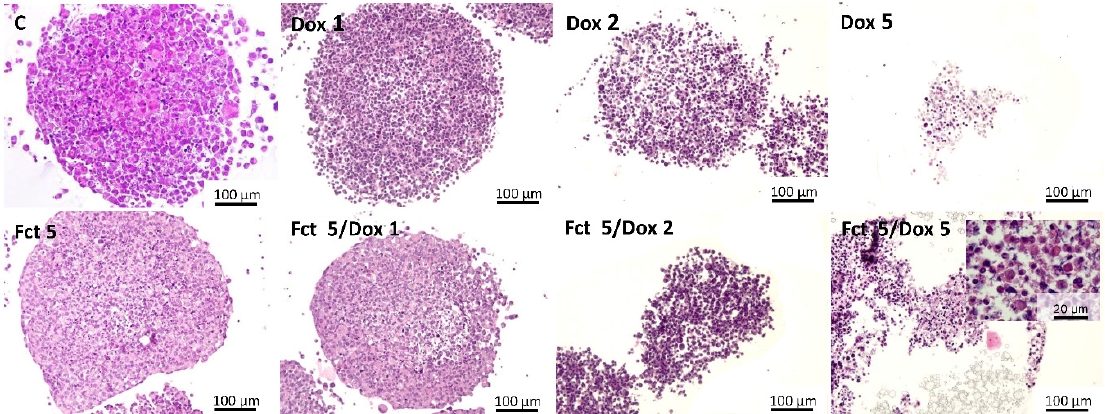
Figure 12. Representative histological images of MCAs exposed to the tested conditions: fucosterol (Fct) 5 μ M alone and in combination with doxorubicin (Dox) 1, 2, and 5 μ M. Cells treated with 0.1% DMSO correspond to the control (C). MCAs sections were stained with hematoxylin-eosin.